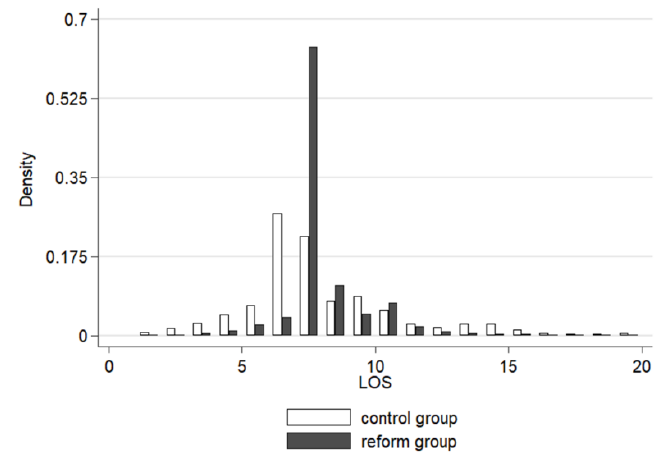
Figure 4. Distribution of the LOS in the control and reform groups. To clearly display the density, a 95% winsorization of the high ends was processed.